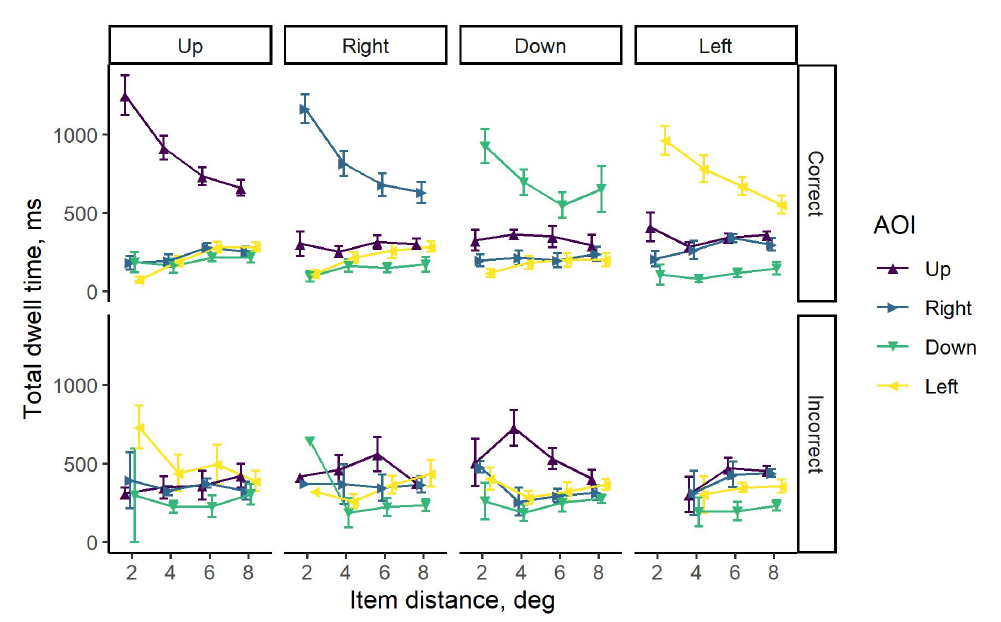
Figure 4. Mean total dwell times for all subjects when responding to 3D images (target-present trials) with items presented at four positions (up, right, down, and left) and four distances from the plane center (2°, 4°, 6°, and 8°) on the multi-plane display. Each column corresponds to a different position of the target. The bars represent the group standard errors. Note that no incorrect responses were submitted when the target was presented to the left from the center of the display plane at 2° distance.